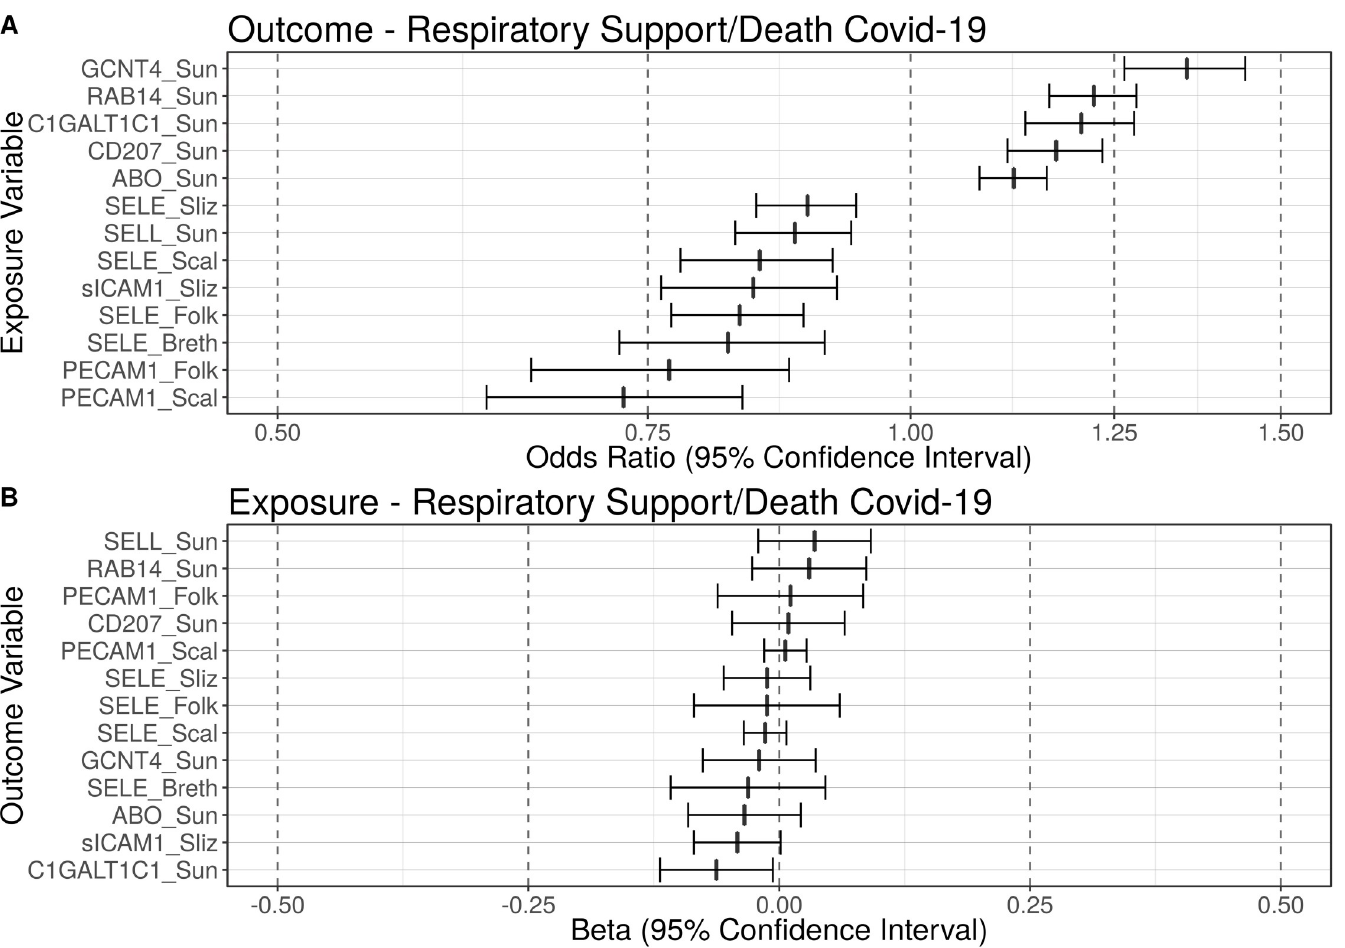
Fig 2. Blood markers putatively causally associated with need for respiratory support/death due to COVID-19. Summary figure of the false discovery rate-corrected (p FDR = 0.05) Mendelian randomization results using the Generalised Summary data-based Mendelian randomization (GSMR) method. Using genetic instruments and under the assumptions of Mendelian randomization, this figure displays: (A) Summary figure when respiratory support/death-COVID-19 is the outcome of interest; (B) Summary figure when respiratory support/death-COVID-19 is the exposure of interest. Odds ratios (ORs) of blood markers causally associated with the need for respiratory support/death due to COVID-19 are displayed on the x-axis (with 95% confidence intervals). The blood markers are displayed on the y-axis. The dashed line at one represents an odds ratio of one (i.e., no effect). Using genetic instruments and under the assumptions of Mendelian randomization, five blood markers were causally associated with a significantly increased risk for need for respiratory support/death due to COVID-19 and eight blood markers were causally associated with a significantly decreased risk for respiratory support/death (q FDR � 0.05). ABO = ABO system transferase; C1GALT1C1 = C1GALT1 specific chaperone 1; CD207 = langerin; GCNT4 = glucosaminyl (N-Acetyl) transferase 4; LCTL = lactase-like protein; PECAM1 = platelet endothelial cell adhesion molecule; RAB14 = ras-related protein rab-14; SELE = E-selectin; SELL = L-selectin; sICAM1 = soluble intercellular adhesion